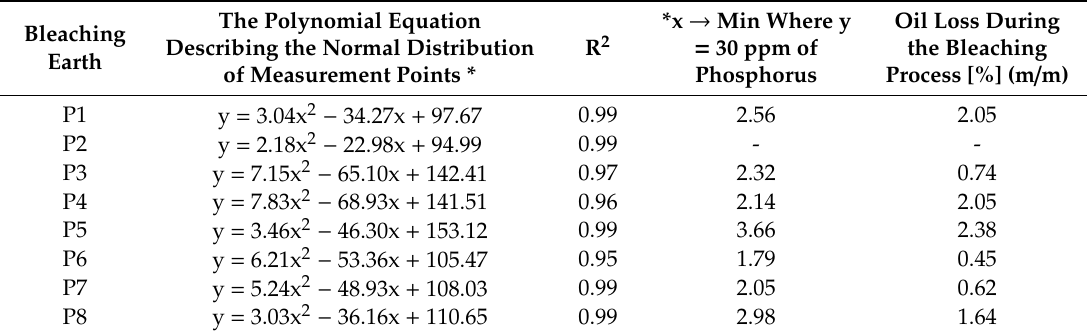
Table 3. Optimal amount of applied bleaching earths and the amount of loss in the low-temperature bleaching